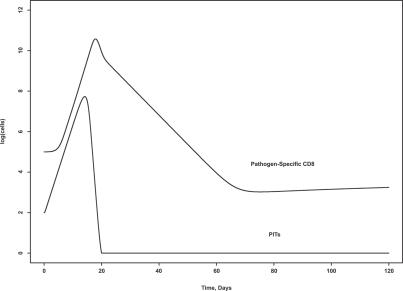
Whole-Body, Deterministic Model Suitable for a Faster, More Immunogenic Pathogen (Bacteria or Virus, but not HIV), with R
0 = 5Progession time, 1/4 day; α = 10−5; κ = 10−9.